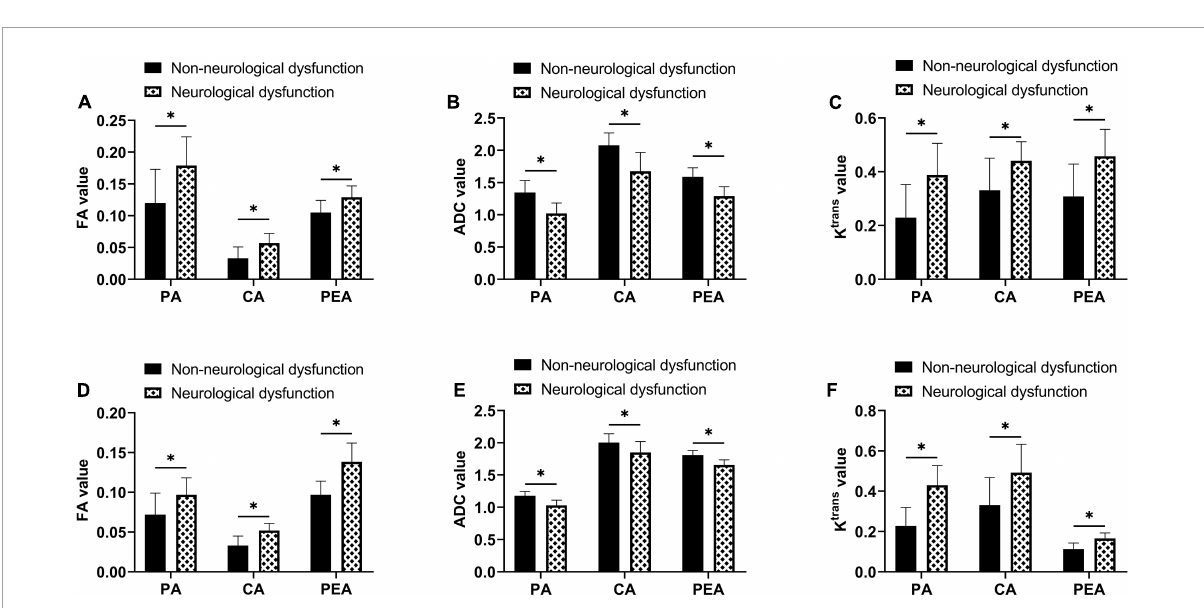
FIGURE6 Association between MRI findings and neurological function. (A) Comparison of FA values of each region of interest between GL patients with and without neurological dysfunction. (B) Comparison of ADC values of each region of interest between GL patients with and without neurological dysfunction. (C) Comparison of K trans values of each region of interest between GL patients with and without neurological dysfunction. (D) Comparison of FA values of each region of interest between MTB patients with and without neurological dysfunction. (E) Comparison of ADC values of each region of interest between MTB patients with and without neurological dysfunction. (F) Comparison of K trans values of each region of interest between MTB patients with and without neurological dysfunction, * P <